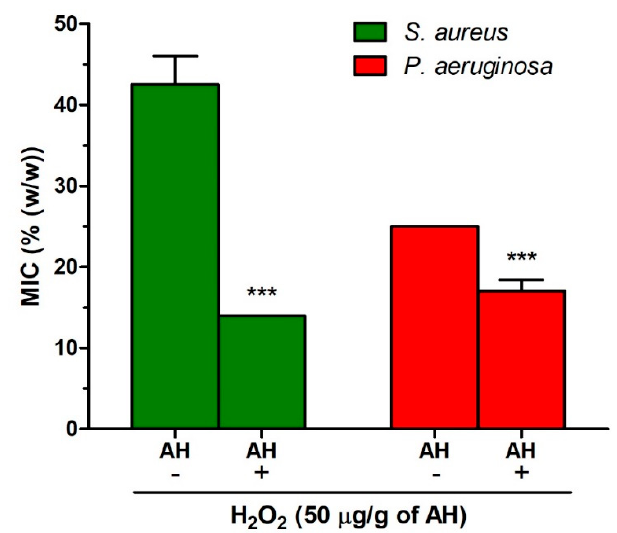
Figure 9. Antibacterial activity of artificial honey (AH) and AH enriched in hydrogen peroxide H 2 O 2 at concentration of 50 μ g/g of AH against Staphylococcus aureus and Pseudomonas aeruginosa isolates. The antibacterial activity was determined with a MIC assay. The MIC was defined as the lowest concentration of honey solution (%) inhibiting bacterial growth. The data are expressed as the mean values with standard deviation. Differences between honey groups were analyzed by t -test. Asterisks indicate a significant difference between control AH and AH enriched in H 2 O 2 , *** P < 0.001.